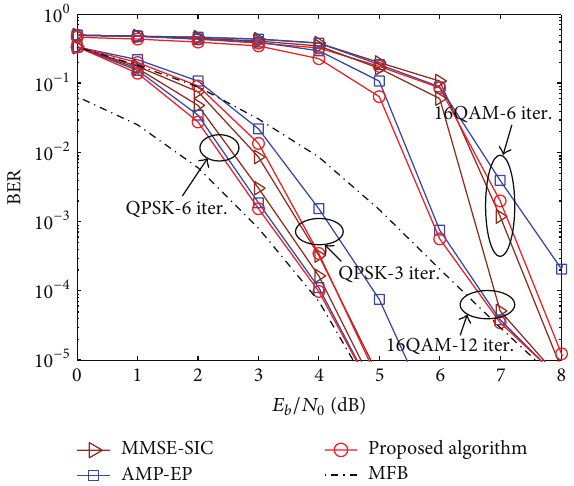
Figure 7: BER performance versus 𝐸 𝑏 / 𝑁 0 for the proposed algo- rithmwithdifferentnumberofiterationsina64 × 64MIMOsystem, QPSK and 16QAM modulation, 16 taps Rayleigh channel with equal tap power.